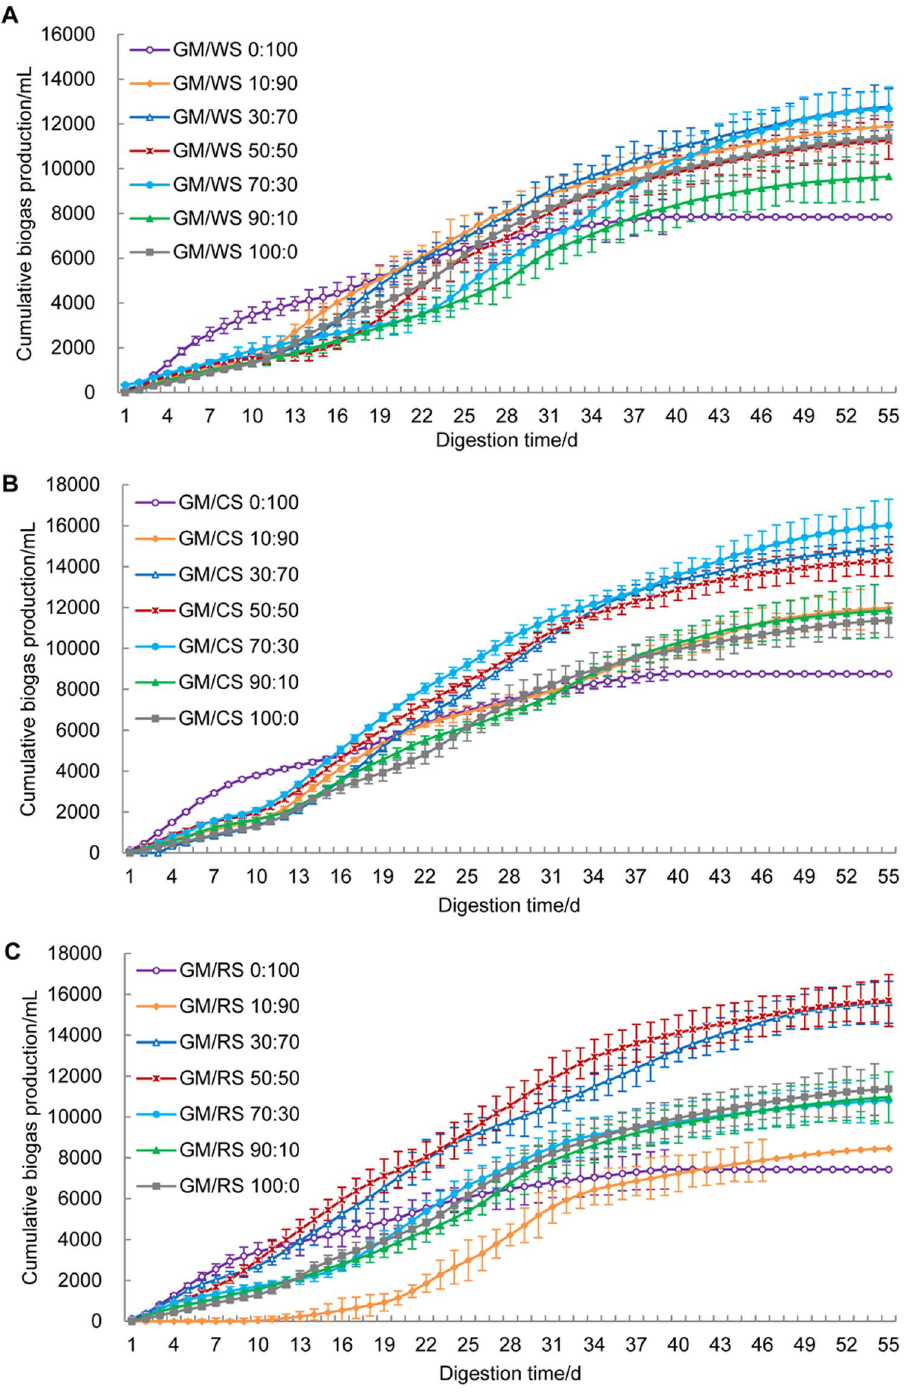
Figure 2. Cumulative biogas productions from co-digestion of GM and WS (A), CS (B) and RS (C) with different mixing ratios. Mean values originated from three independent replications. Vertical bars represent standard